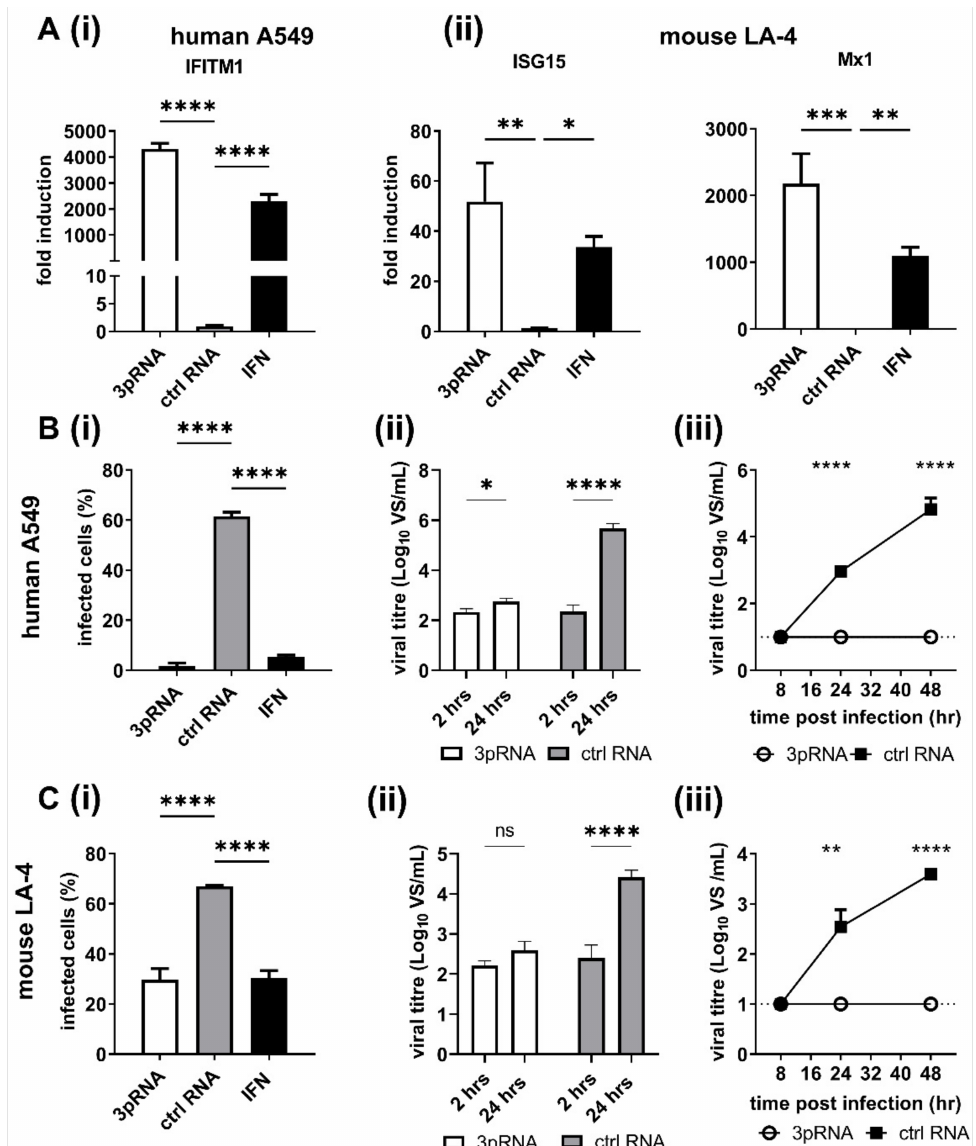
Figure 1. Treatment of human and mouse airway cell lines with RIG-I agonist induces ISG expres- sion and inhibits IAV infection and replication. LA-4 and A549 cells were transfected with RIG-I agonist (3pRNA, 200 ng/mL) or control RNA (ctrl RNA, 200 ng/mL), or incubated with human (10 4 units/mL) or mouse (10 4 units/mL) IFN- α . ( A ) After 24 h, total RNA was isolated and ex- pression of ISGs assessed by qRT-PCR. Expression is normalized to GAPDH and expressed as fold induction relative to untreated cells. ( B ) human A549 or ( C ) mouse LA-4 cells, were (i) inoculated for 1 h at 37 ◦ C with IAV (strain HKx31) at MOI of 5 (A549) or 10 (LA-4). Cells were incubated an additional 7 h, then fixed and stained for intracellular expression of the viral NP and analysed by flow cytometry. (ii) Cells were inoculated for 1 h with HKx31 MOI of 5 (A549) or 10 (LA-4), washed and cell-free supernatant was harvested at 2 hpi or 24 hpi. (iii) Cells were incubated at 37 ◦ C in the presence of exogenous trypsin (0.5 mg/mL). In ( B , C ) (ii) and (iii) titres of infectious virus were determined in clarified supernatants at various times post-infection using a VS assay on MDCK cells. All data show the mean ( ± SD) from triplicate samples and are representative of 2 or more independent experiments except for ( C ) (ii), where one experiment in triplicates was performed. A one-way ANOVA with Bonferroni’s multiple comparison test was used in ( A ),( B (i)) and ( C (i)) and a Student’s unpaired t -test was used in ( B (ii),(iii)) and ( C (ii),(iii)) to compare 3pRNA or ctrl RNA treatment. * = p < 0.05; ** = p < 0.01; *** = p < 0.001; **** = p <